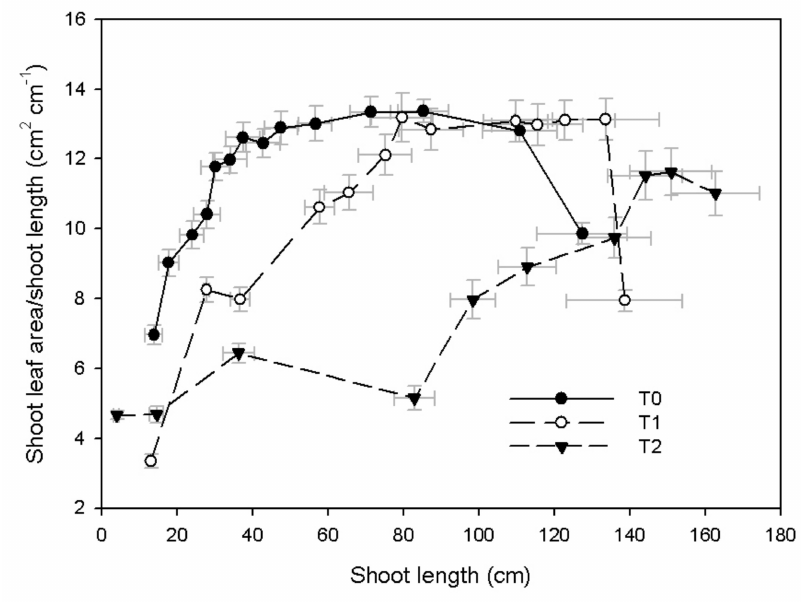
Figure 4. Shoot leaf area/shoot length vs. shoot length in T0, T1, and T2 vines ( n = 4). Mean ±